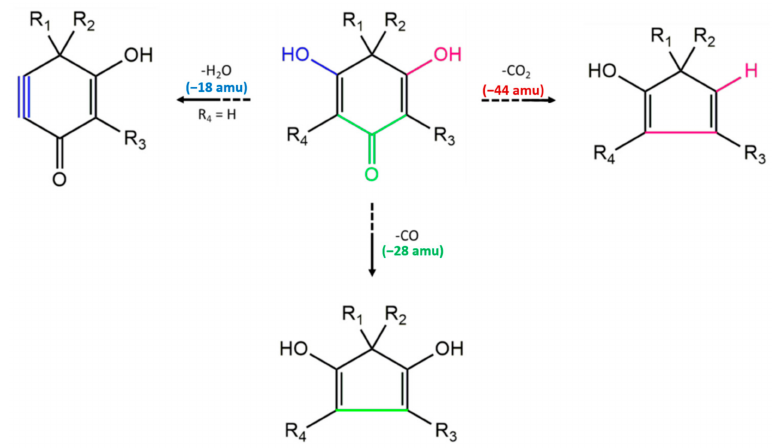
Figure 5. Characteristic proposed fragmentations for monomeric PIB derivatives. The “blue” path leads to the elimination of a molecule of water and to the formation of a triple bond. The “green” path leads to the elimination of a carbonyl group, with further rearrangement of the ring. The “purple” path leads to the elimination of CO 2 , followed by rearrangement of the